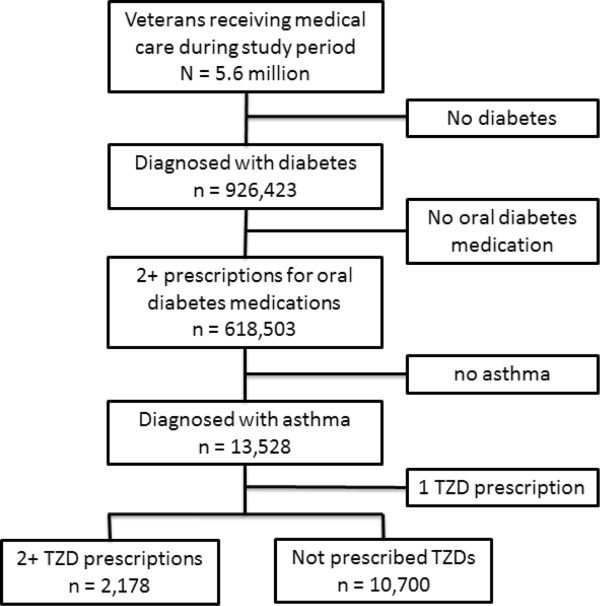
Study selection.